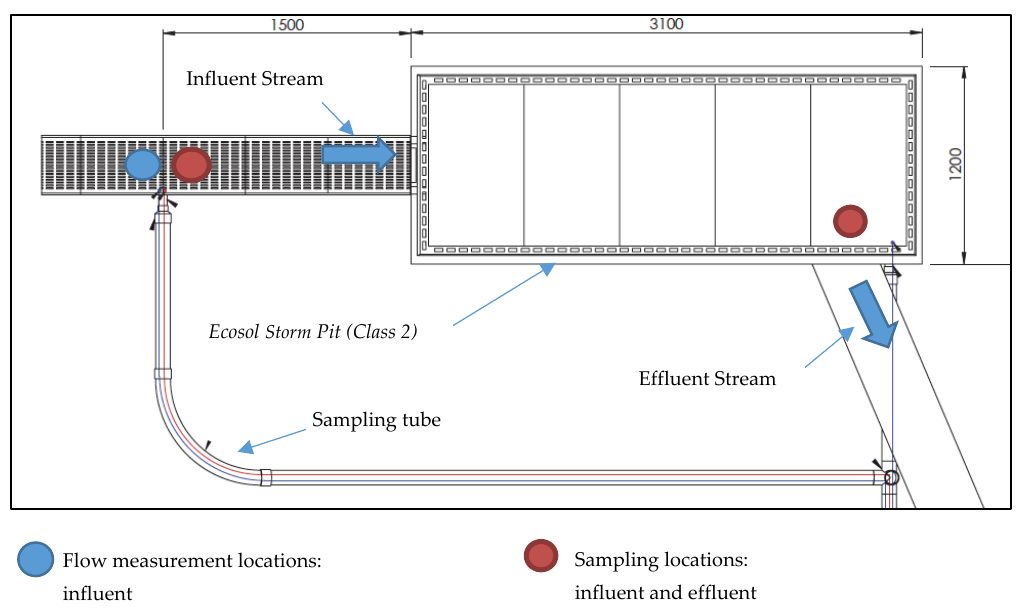
Figure 4. Flow sensors and sample intake locations [8].